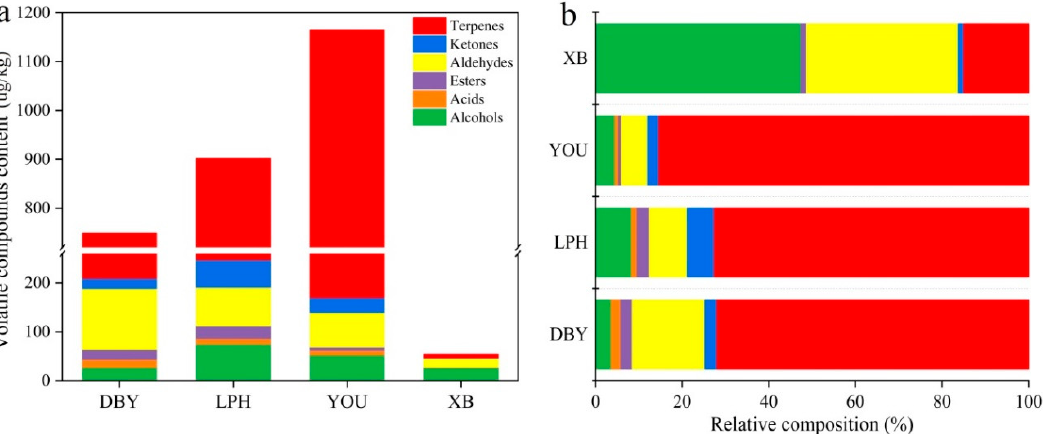
Figure 1. The content ( a ) and relative composition ( b ) of volatile compounds in four different apricot cultivars. DBY, Dabaiyou apricot; LPH, Luopuhongdaike apricot; YOU, You apricot; XB, Xiaobai apricot.